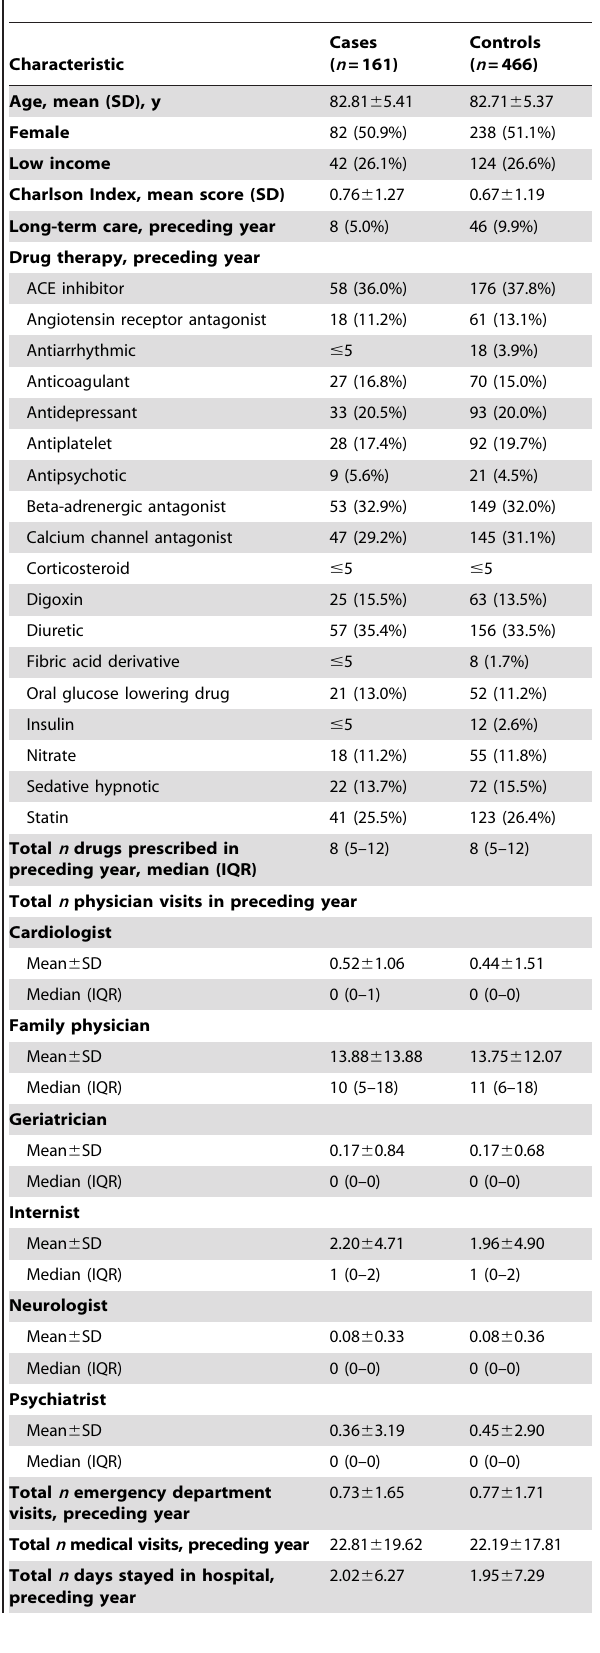
Table 1. Characteristics of cases and